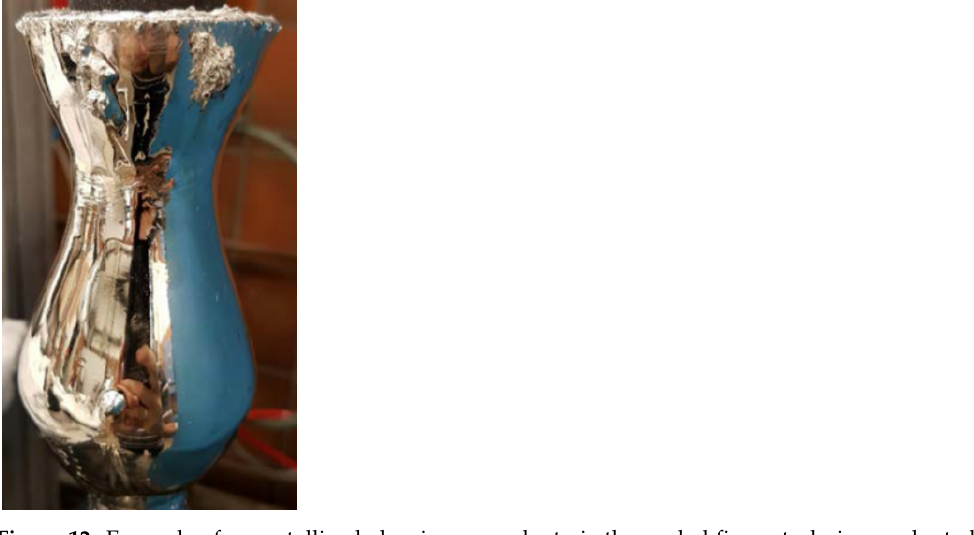
Figure 12. Example of a crystallized aluminum product via the cooled finger technique, adapted from